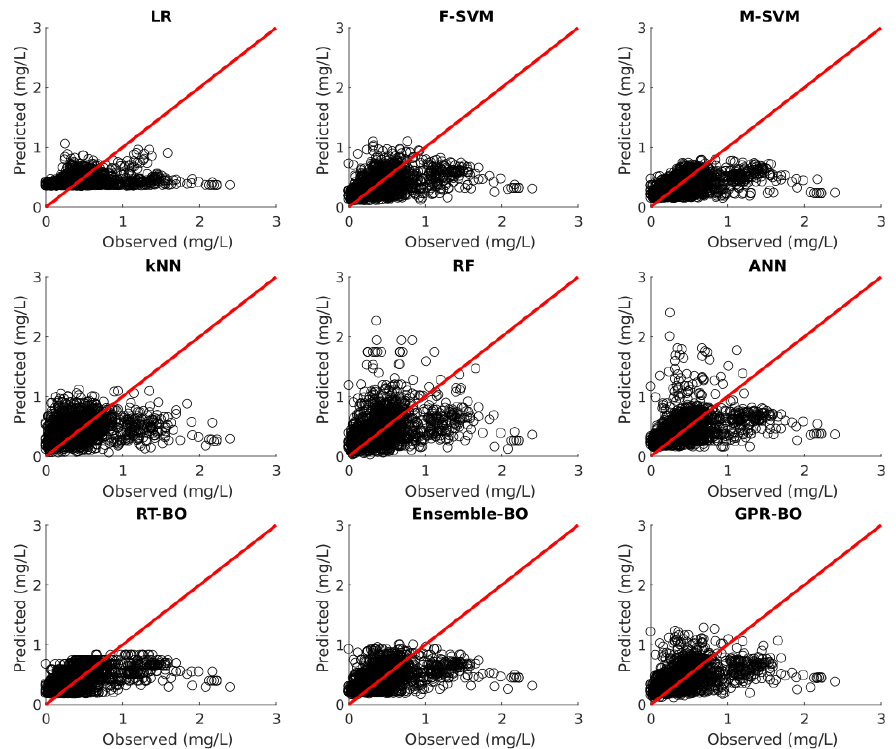
Figure 3. Observed versus predicted daily nitrate concentration for the Grand watershed using different ML algorithms.